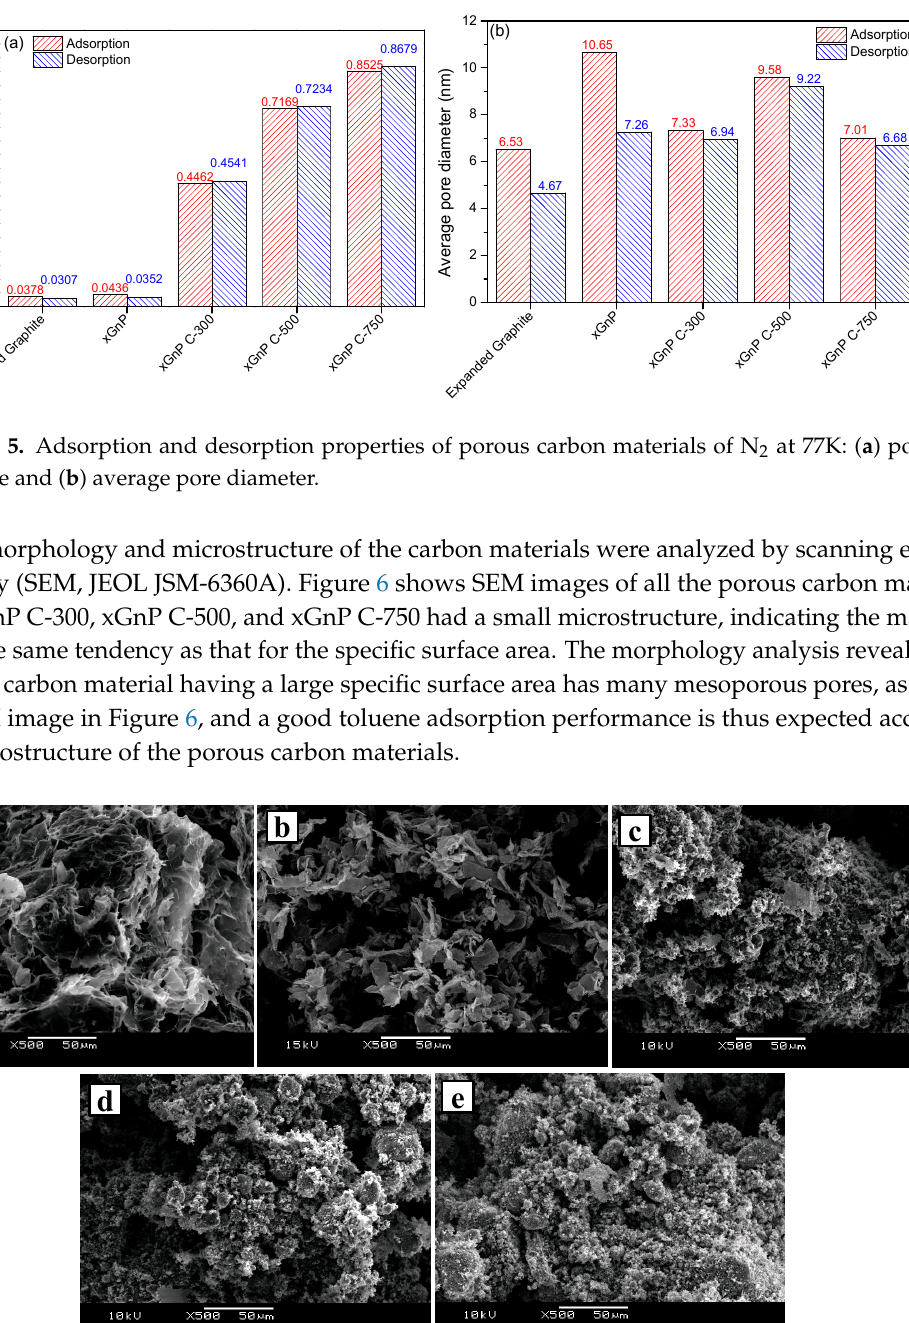
Figure 6 . SEM image of porous carbon materials: ( a ) EG; ( b ) xGnP; ( c ) xGnP C-300; ( d ) xGnP C-500; and ( e ) xGnP C-750.